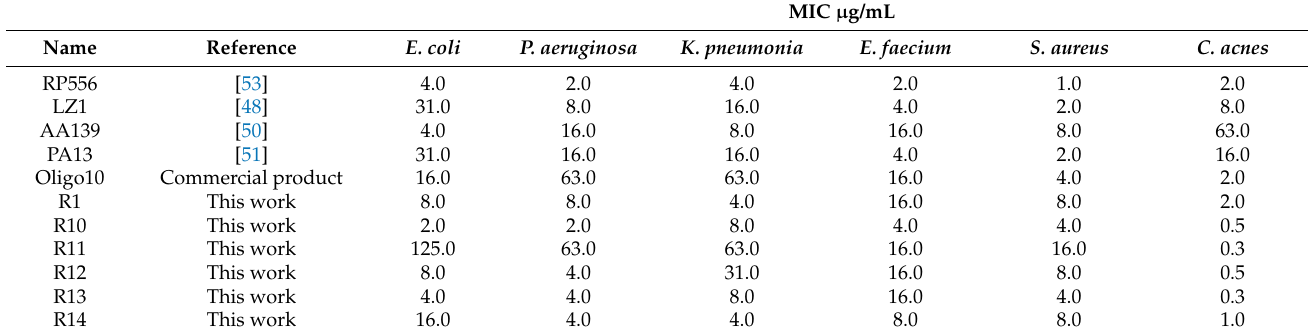
Table 2. Minimal inhibitory concentrations (MIC) of antimicrobial peptides against selected bacteria, µ